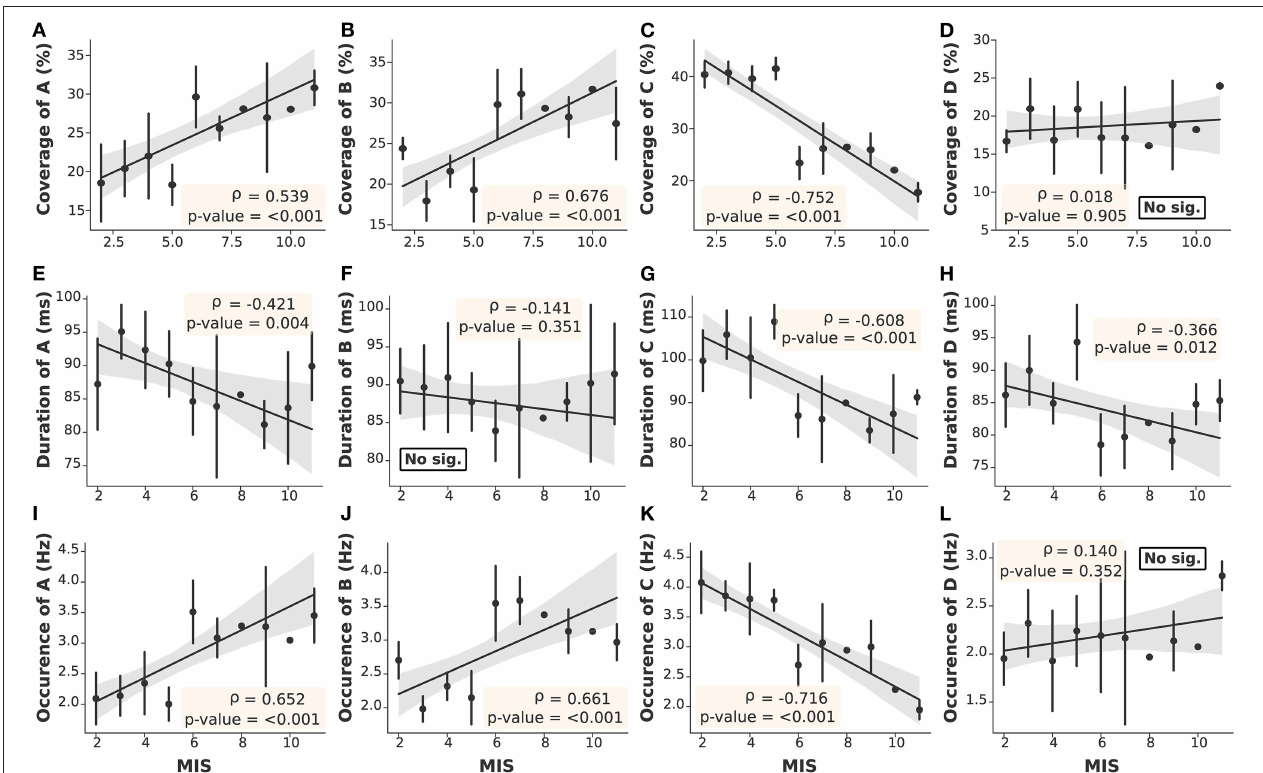
FIGURE 4 | The correlation between the MIS and microstate parameters in each prototype was obtained by Spearman’s rank order correlation test. With the exceptions of (D,F,L) , the remaining parameters (A–C,E,G,H–K) demonstrated significant correlations with the MIS (Gray: 95% CI, point: Z-score mean, vertical line: